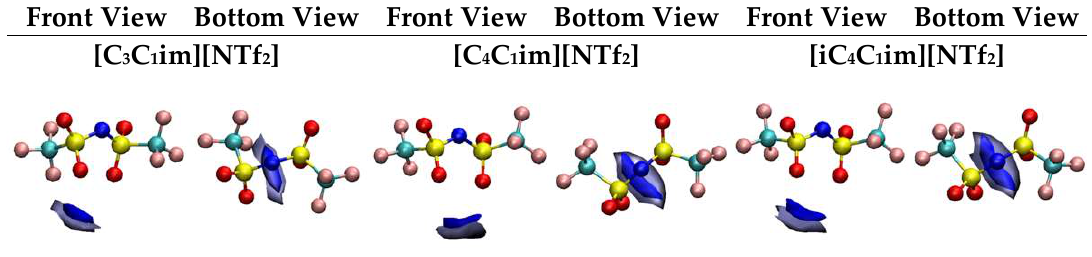
Figure 3. Selected spatial distribution functions around the [NTf 2 ] − anion in aqueous mixtures X IL = 0.70 (wt IL = 98%) of [C 3 C 1 im][NTf 2 ], [C 4 C 1 im][NTf 2 ], and [iC 4 C 1 im][NTf 2 ] at 320 K. The blue color represents the H atom of cations attached to the C2 carbon between nitrogen atoms of the imidazolium ring and light blue depicts the water O atom. The isosurface value is 70% of the maximum number density.